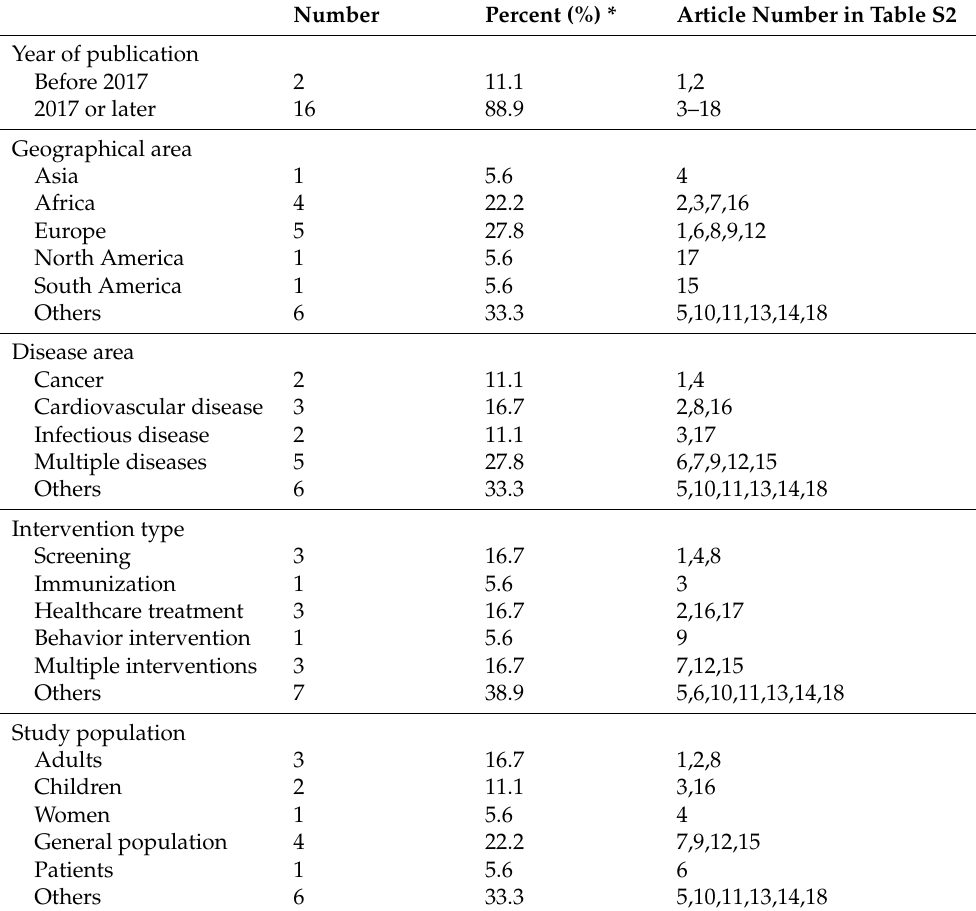
Table 1. General characteristics of the included studies (N =